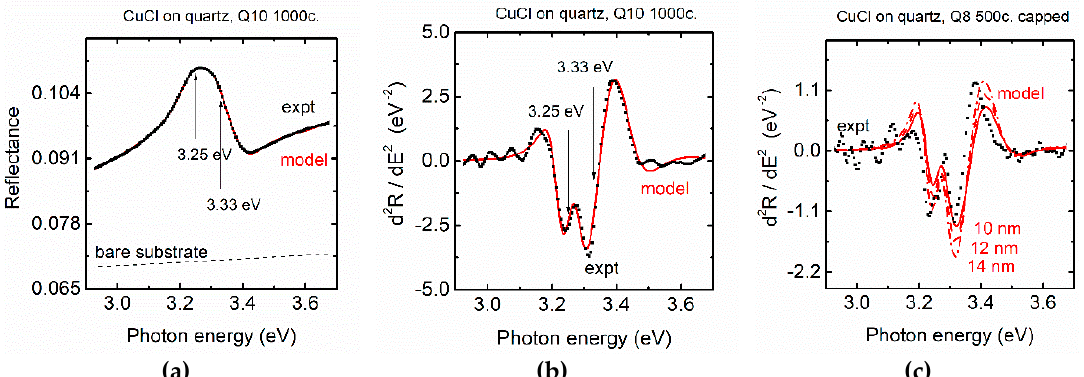
Figure 10. ( a ) Normal incidence reflectance spectra of the uncapped, 1000 c. sample; the positions of two prominent Gaussian bands are indicated by arrows, bare substrate (dashed line); ( b ) second derivative; and ( c ) second derivative of the reflectance spectrum from the capped, 500 c. sample. Measured data (symbols), model lineshapes (red solid and dashed lines). Table 7. Best-fit parameters of the Gaussian bands used in modelling the reflectance spectra of Figure 10. Band Strength (a.u.) Position (eV) Width (eV)